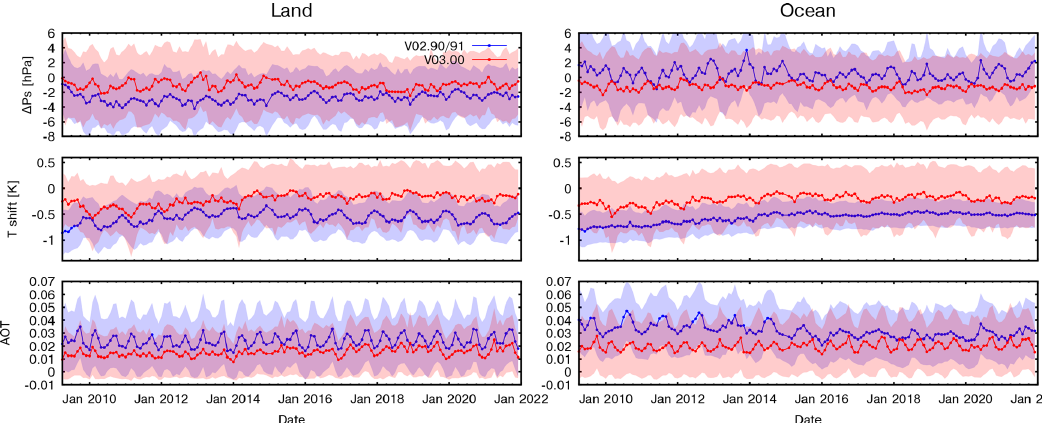
Figure 10. Time series of the monthly averaged (cid:49)P s , T shift, large particle AOT at 1.6µm from V02.90/91 and V03.00. The shades show ± 1 σ